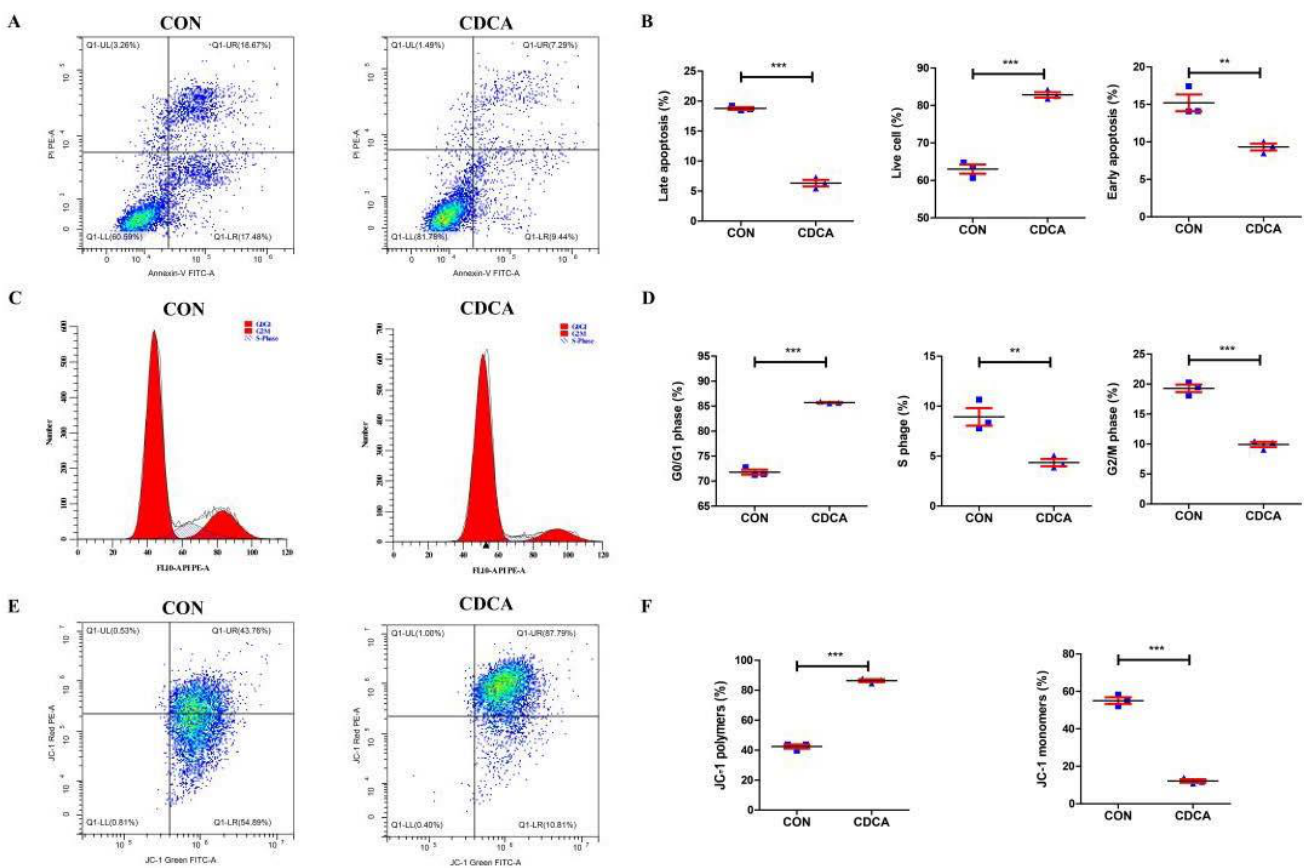
Figure 3. Effects of CDCA on cell apoptosis, cell cycle, and mitochondrial membrane potential of IPEC-J2 cells ( n = 3). The representative flow cytometry (FCM) plots of cell apoptosis ( A ) as well as the proportion of late apoptosis cells, live cells, and early apoptosis cells ( B ). The representative FCM plots of the cell cycle ( C ) as well as the proportion of cells in G0/G1, S, and G2/M phases ( D ); The representative FCM plots of cell mitochondrial membrane potential ( E ) as well as the proportion of cells with JC-1 polymers (high membrane potential) and JC-1 monomers (low membrane potential) ( F ). Values are presented as mean ± SEM. ** p < 0.01, *** p < 0.001 compared with the CON group.